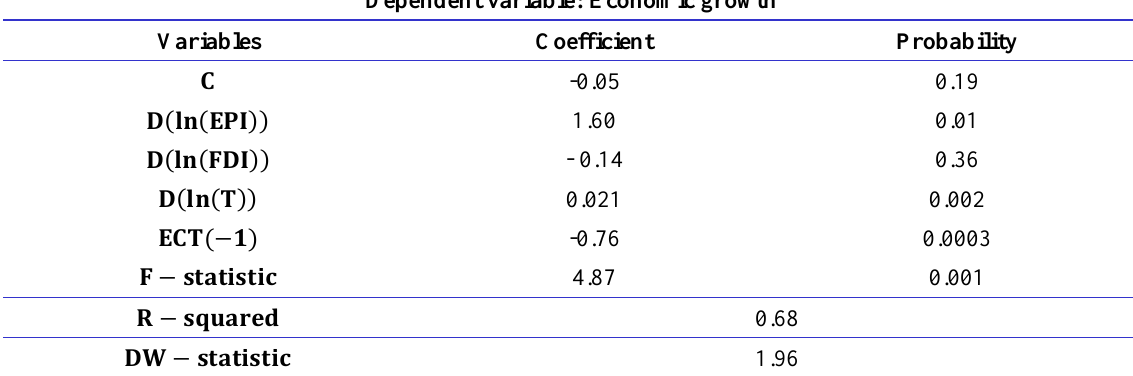
Table 5. Results of short-run model assessment Dependent variable: Economic growth